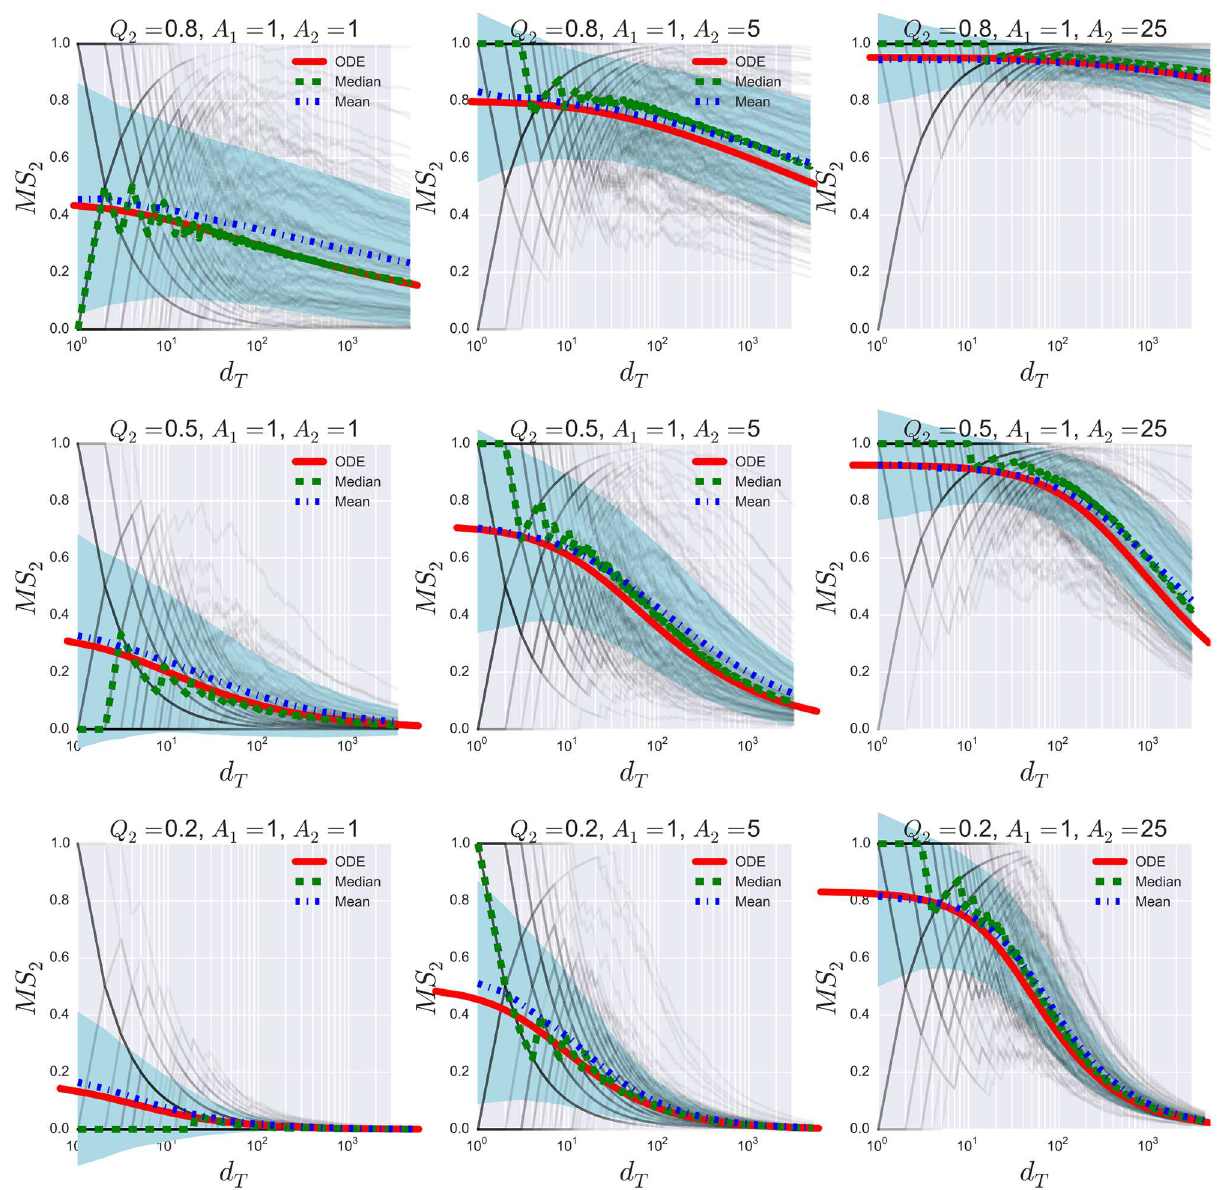
Fig 3. Monte carlo simulations and ODE solutions of the market shares for asymetricappeals. The Monte Carlo simulations involved 10 4 realizationsof the system for nine different sets of parameters (grey lines). In all cases, q 1 = 1 and both products start with zero purchases,i.e., d 1 ( t = 0) = d 2 ( t = 0) = 0. AlthoughMonte Carlo simulations producediscrete dots in the ( d T , MS 2 ) space, we plot each simulationwith straight lines that link consecutivedots to follow trajectories easily.